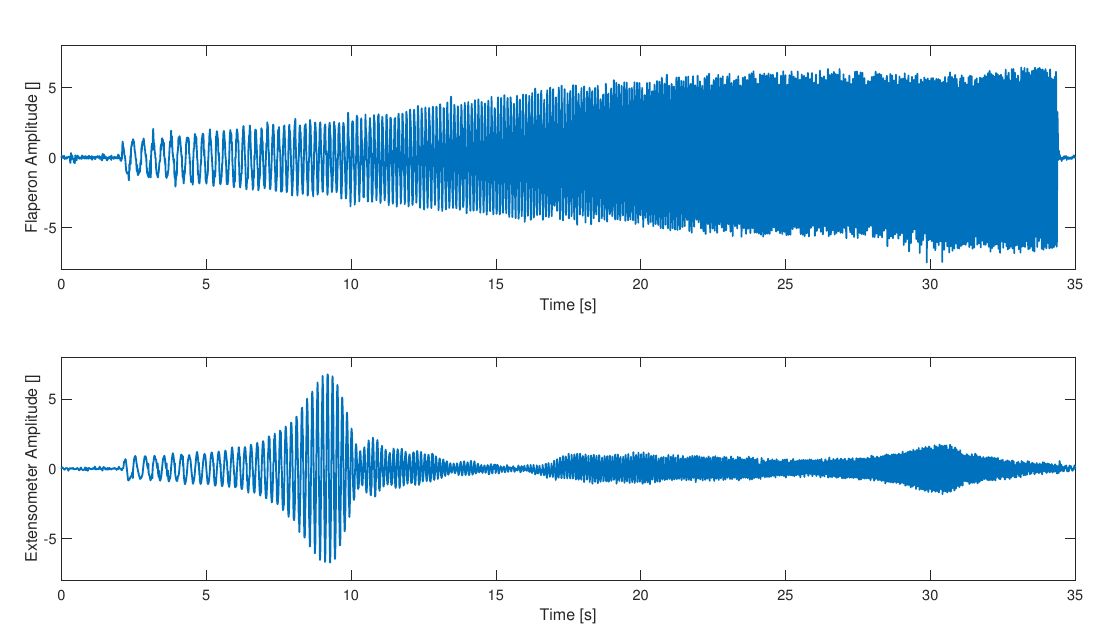
Figure 3. Frequency Sweep sample plot extracted from real Flutter Flight Test data. The upper plot shows the forced excitation on the flaperon through the Flight Controls, while the lower plot shows the reading from the wing extensometers.